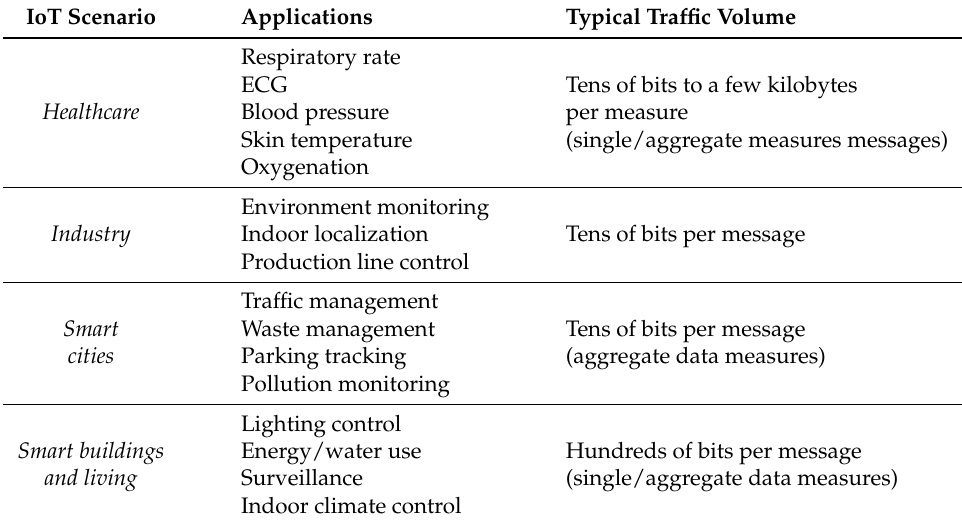
Table 1. Typical IoT LPWANs use